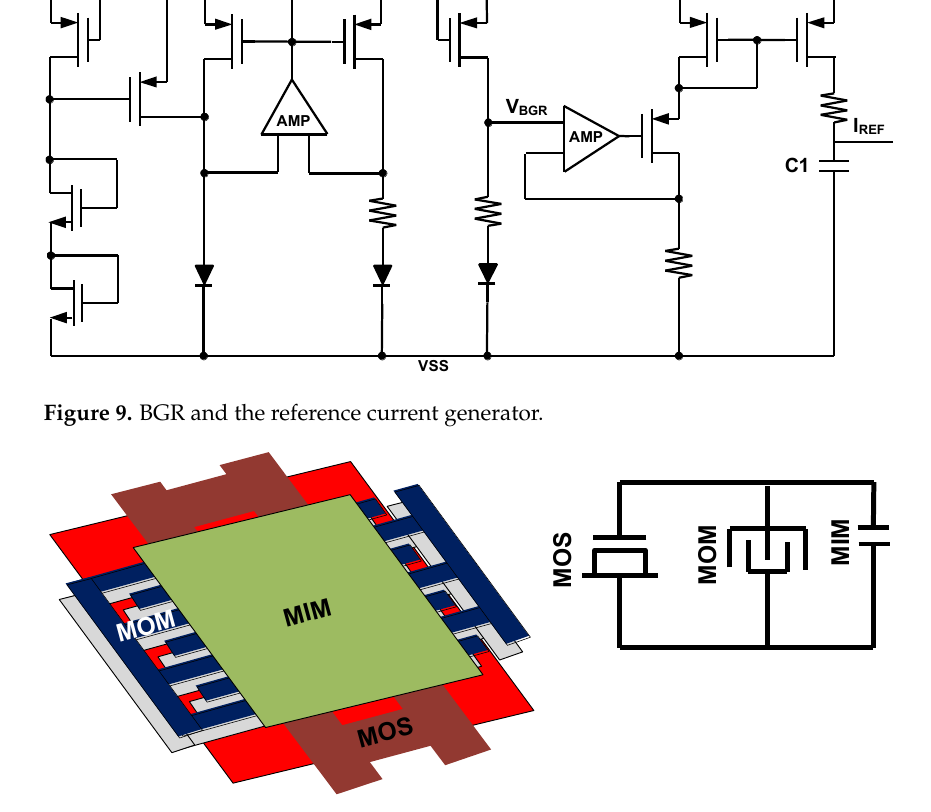
Figure 10. Custom-made capacitor made of MOS, MOM and MIM